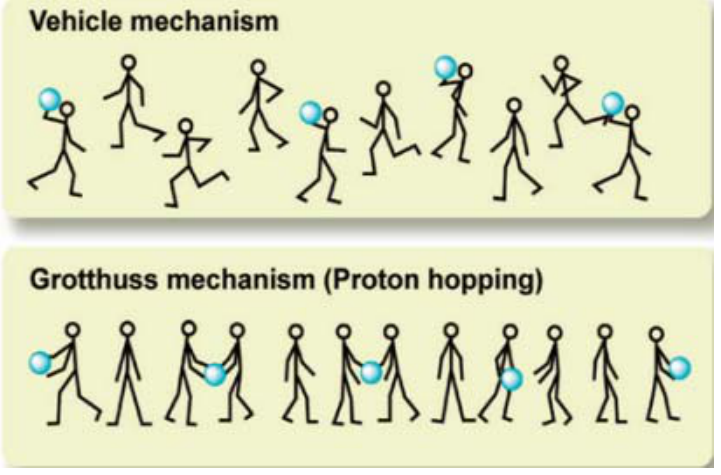
Figure 2. Scheme of proton transfer mechanisms (vehicle and Grotthuss